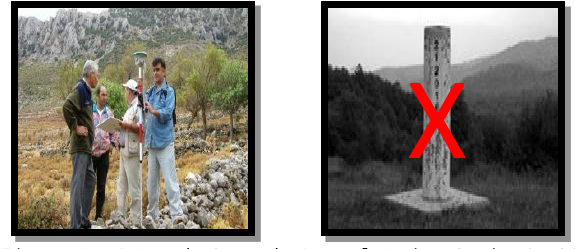
Figure 7. C-Rated Ground Control Point Static GNSS Measurement